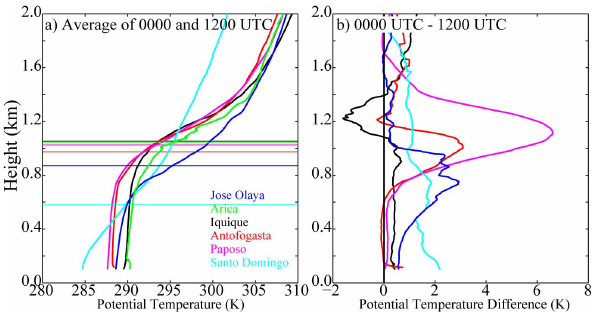
Fig. 11. (a) Average profile of potential temperature (K) for all 00:00 and 12:00UTC coastal soundings during VOCALS-REx and (b) difference between average 00:00UTC and average 12:00UTC potential temperature profiles. Horizontal lines indicate the average MBL